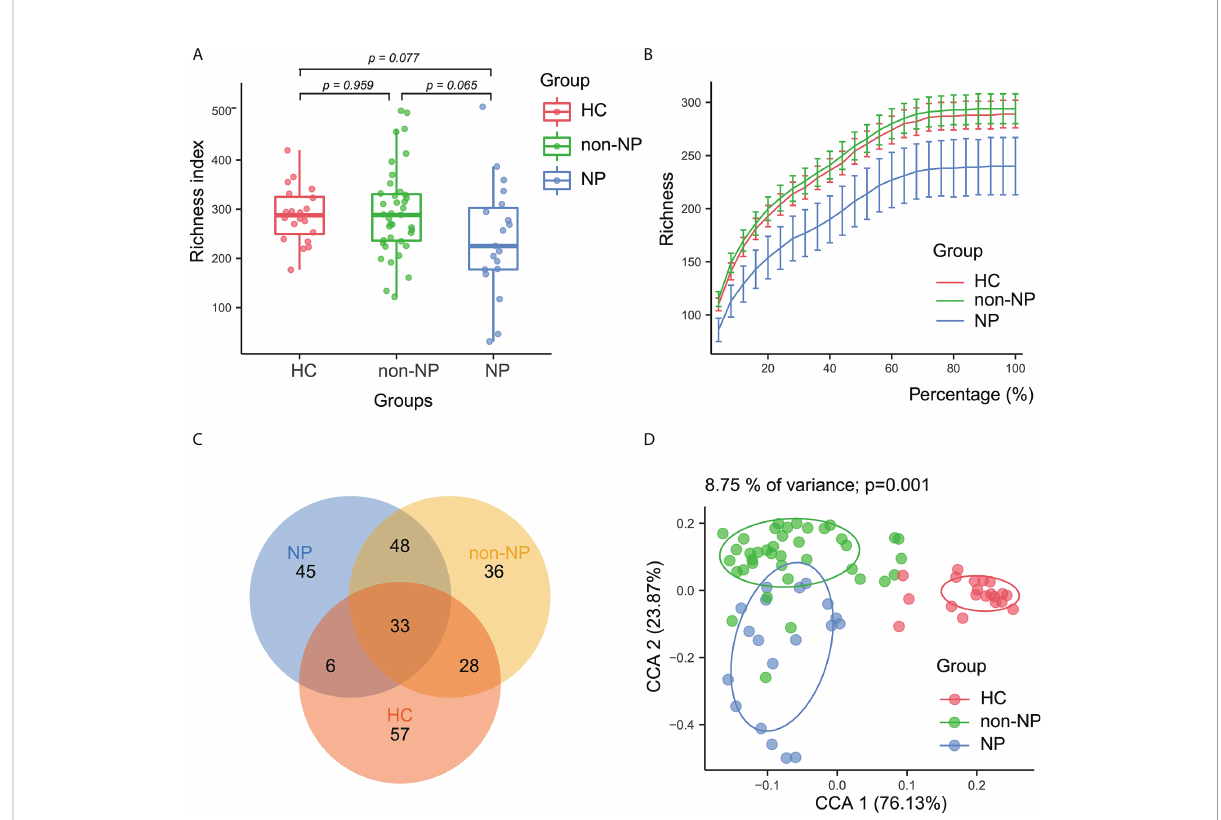
FIGURE 1 Alpha and beta diversity analysis between NP, non-NP and healthy control groups. (A) Alpha diversity based on richness index. Box-plot features represent the median (central line), upper and lower quartiles (box), and the maximum and minimum values of the data (bars). (B) A refraction curve demonstrating species richness. (C) A Venn diagram demonstrating the existence of ASVs in each group. (D) Beta diversity analysis based on CPCoA plot. Each symbol represents the gut microbiota of a sample. NP, necrotizing pancreatitis; non-NP, non-necrotizing pancreatitis; CPCoA, constrained principal coordinate